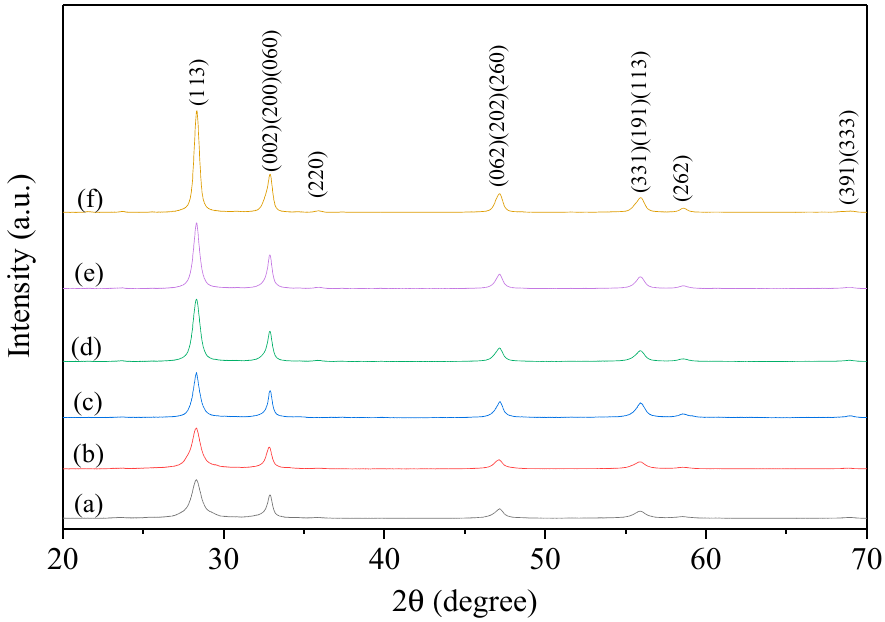
Figure 1. X-ray di ff raction patterns of the Bi 2 WO 6 samples: ( a ) BWO1, ( b ) BWO2, ( c ) BWO3, ( d ) BWO4, Figure 1. X-ray diffraction patterns of the Bi 2 WO 6 samples: (a) BWO1, (b) BWO2, (c) BWO3, (d) BWO4, ( e ) BWO5, and ( f ) BWO6. Profiles are shifted in y-scale for (e) BWO5, and (f) BWO6. Profiles are shifted in y-scale for clarity. Table 2. Rietveld structural parameters of the samples. Samples